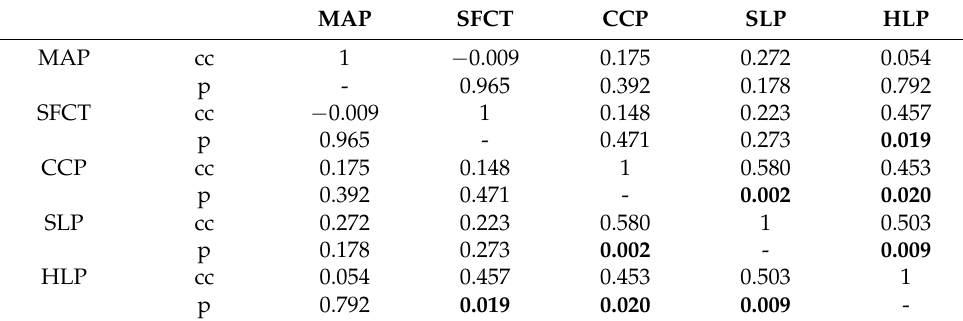
Table 4. Correlation analysis of the pregnant